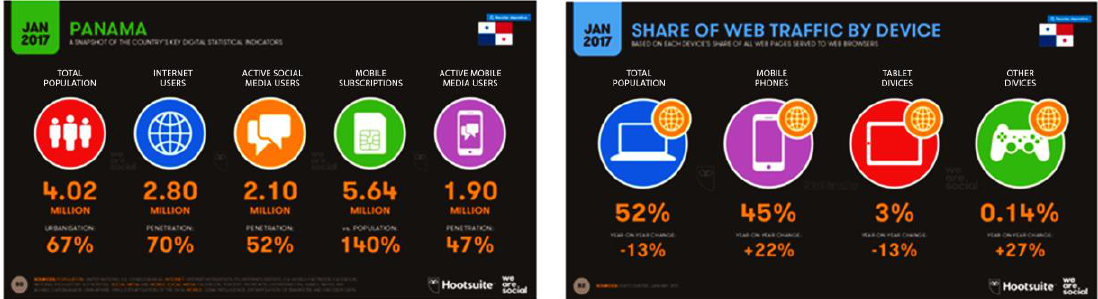
Figure 9. Statistics in Panama on telephony and Internet connection [17].